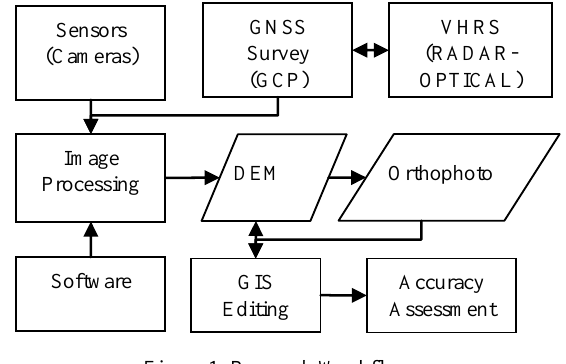
Figure 1. Research